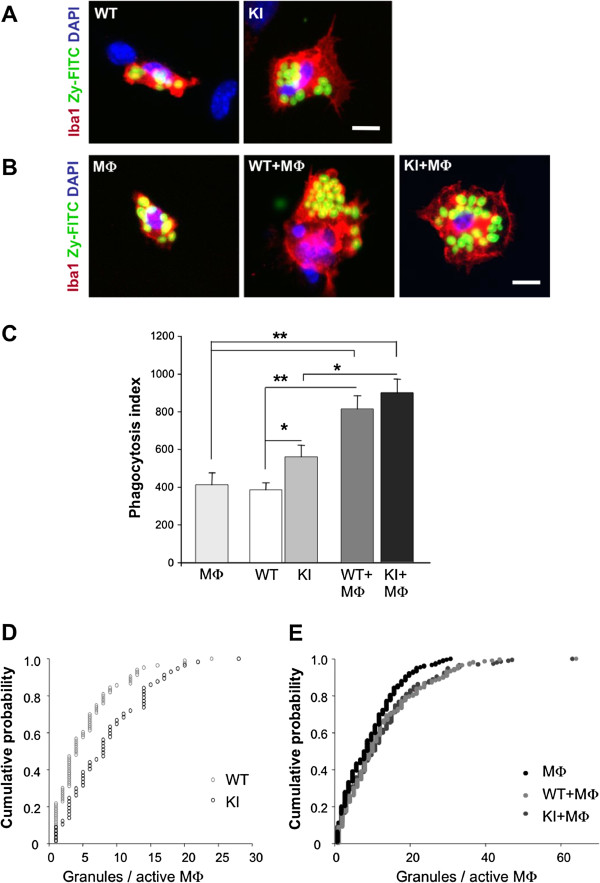
Macrophage functional activity in culture. A, Examples of fluorescence microscopy images of macrophages (immunostained with anti-Iba1 antibody; red) in WT or R192Q KI trigeminal ganglion cultures. Active Iba1 immunoreactive macrophages show inclusion of round-shaped Zy-FITC granules (green). Cell nuclei are shown in blue (DAPI). Scale bar = 10 μm. B, Images show peritoneal macrophages in culture (MФ). and macrophages/trigeminal co-cultures (WT+MФ and KI+MФ) processed like in A. Scale bar = 10 μm. C, Phagocytosis index for WT or R192Q KI cultures; n = 5 petri dish per group: * p < 0.05; ** p < 0.01. D, E, Cumulative probability plots to calculate the occurrence of granule uptake in endogenous Iba1 cells in WT (grey triangles, n = 93 cells) or R192Q KI cultures (squares, n = 64) as well as for peritoneal macrophages (MФ, black circles, n = 241), and from co-cultures (WT+MФ. inverted triangles, n = 202. and R192Q KI (KI+MФ .diamonds, n = 234).